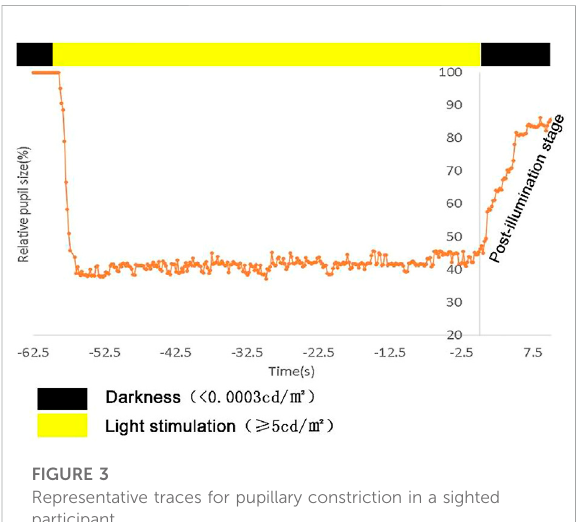
FIGURE 3 Representative traces for pupillary constriction in a sighted